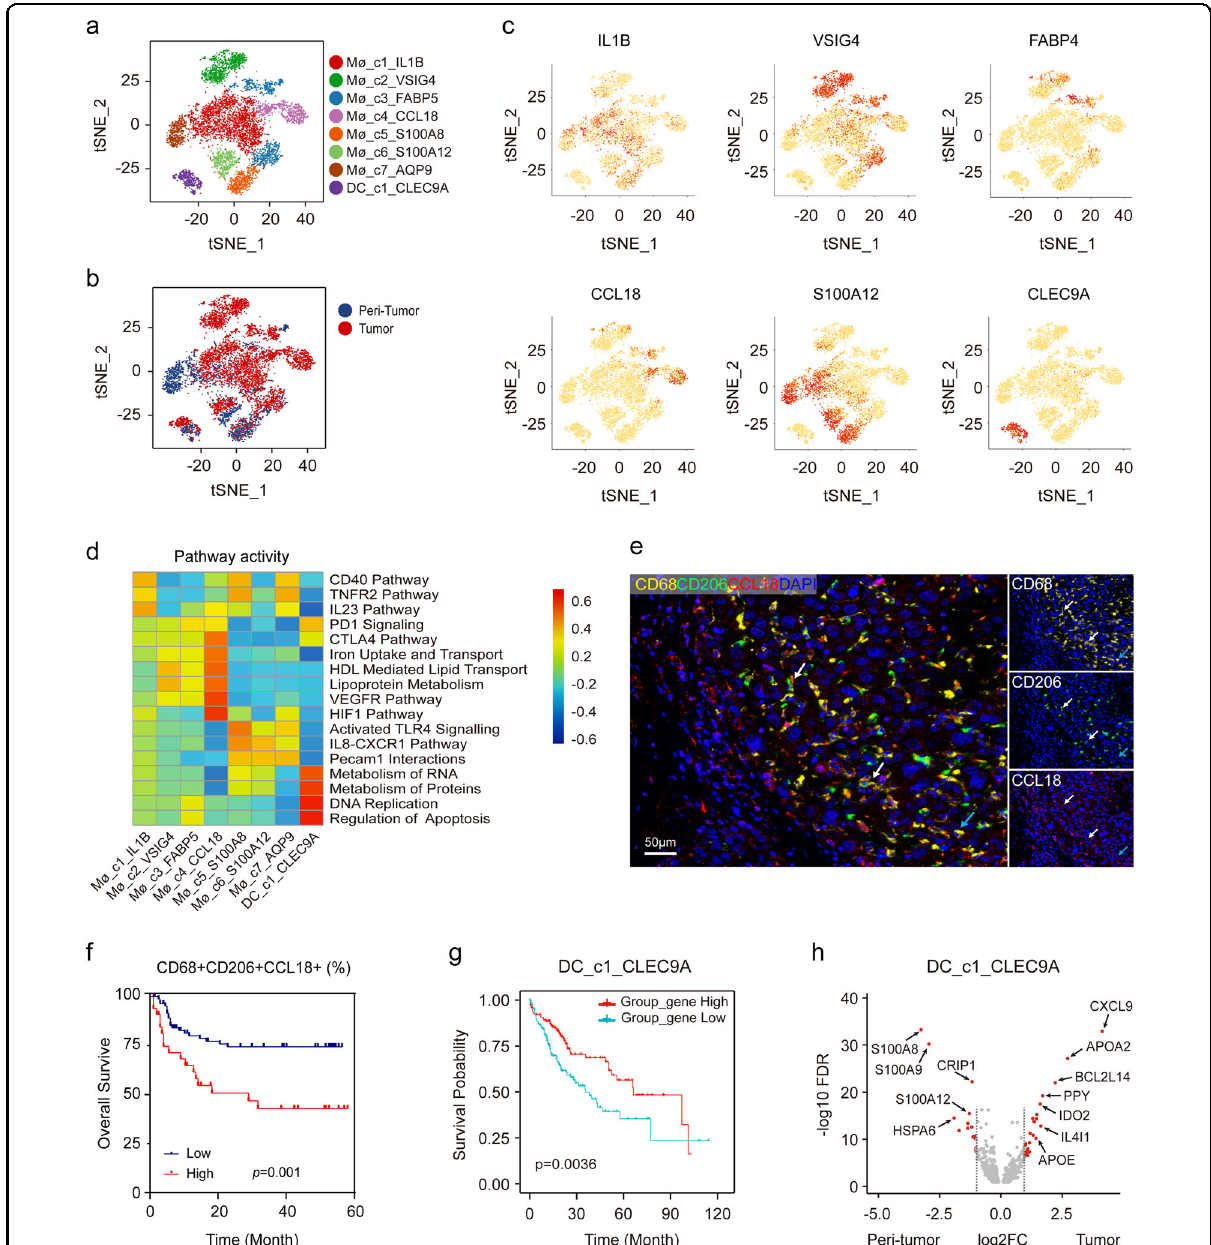
Fig. 2 Identifying distinct myeloid cell clusters in HCC. a t-SNE projection of eight subsets of myeloid cells (each dot corresponds to one single cell) shown in different colors. b t-SNE plots of different myeloid cell clusters origin. c Expression of marker genes for each cluster illustrated in the t- SNE plots. d Heatmap of the differences in pathway activities scored per cell by GSVA analysis. e Representative mIHC images to show the distribution of CD68 + CD206 + CCL18 + macrophages: CD68 (yellow), CD206 (green), CCL18 (red), and DAPI (bule). White arrows (CD68 + CD206 + CCL18 + ), blue arrow (CD68 + CD206 + CCL18 − ). Scale bar, 50 μ m. f Kaplan – Meier curve showing poor survival in patients with high proportion of CD68 + CD206 + CCL18 + macrophage vs low proportion (log-rank test, P = 0.001) in our cohort. g Kaplan – Meier curves of survival for the TCGA HCC patients grouped by the average expression (high versus low) of DC_c1_CLEC9A cell marker genes as annotated in Table S3. (log-rank test, P = 0.0036). h Volcano plot showing differentially expressed genes in DC_c1_CLEC9A cells between peri-tumor and tumor. Each red dot denotes an individual gene passing our P value and fold change